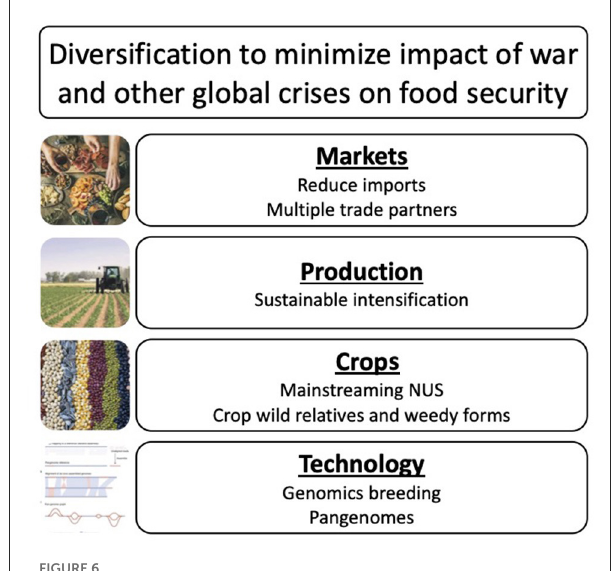
FIGURE6 Diversification of four agrifood systems for global food